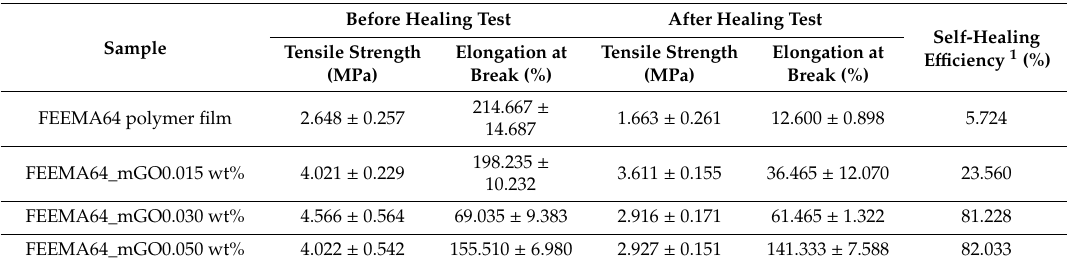
Table 2. Self-healing e ffi ciencies and mechanical properties of FEEMA64_mGO series before and after the healing test.